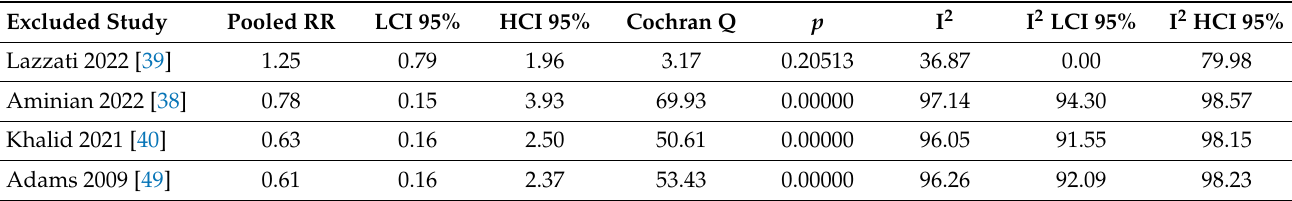
Figure A20. Prostate cancer random effects model funnel plot. Table A20. Prostate cancer random effects model sensitivity analysis.